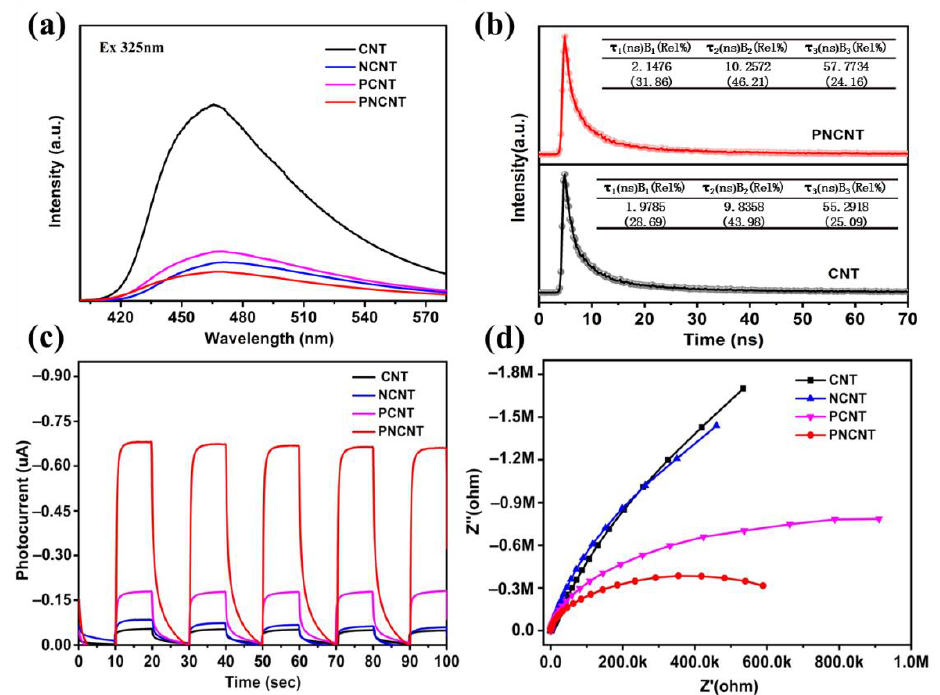
Figure 8. Photoluminescence spectra ( a ), PE-TA spectra of CNT and PNCNT ( b ), the periodic on/off photocurrent response under visible-light irradiation ( c ) and electrochemical impedance spectroscopy plots ( d ) of CNT, NCNT, PCNT and PNCNT samples.